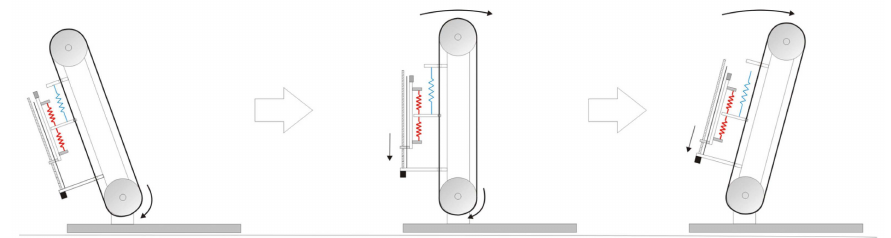
Figure 13. Process of an active step using BIASAT mechanism.